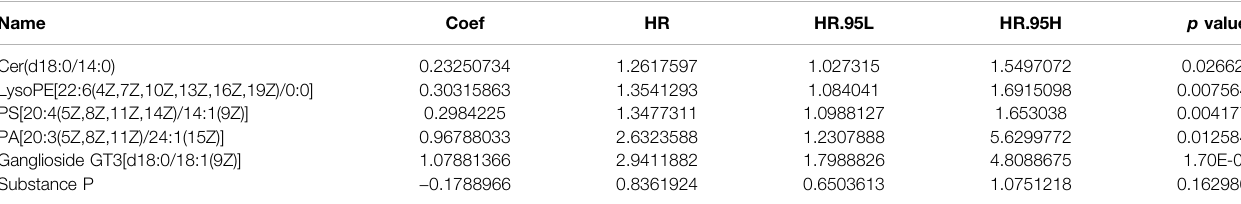
TABLE 3 | Multivariate Cox regression analysis for the survival-associated lipid